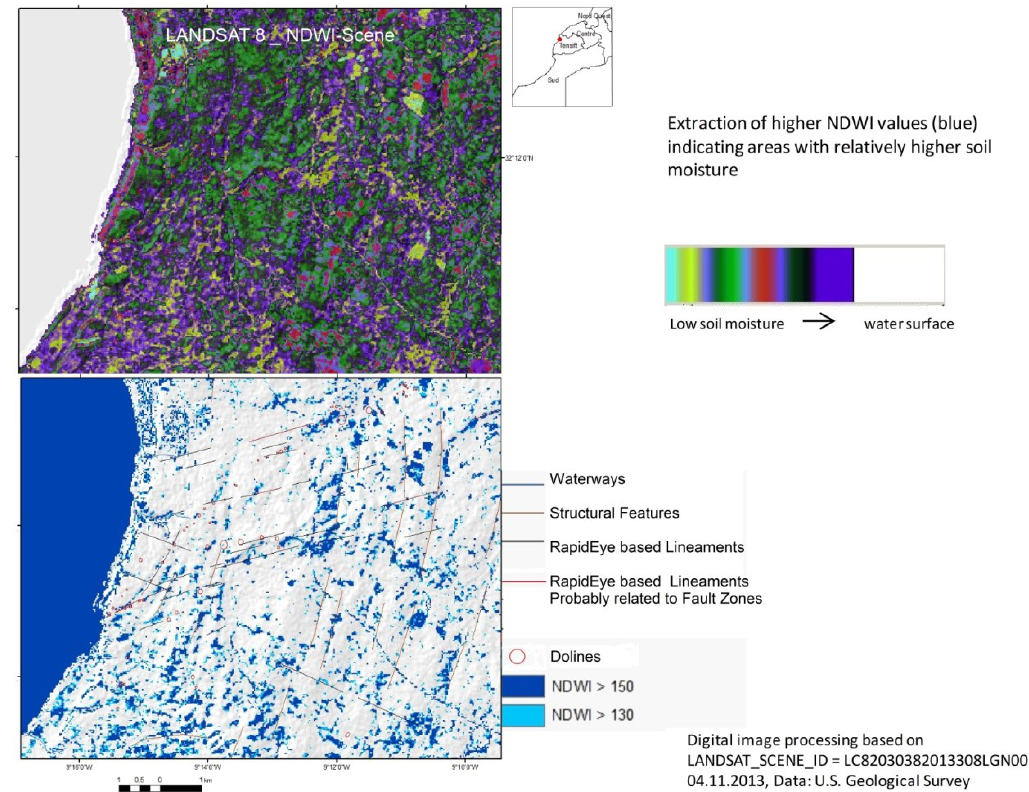
Figure 13. Water index NDWI derived from Landsat